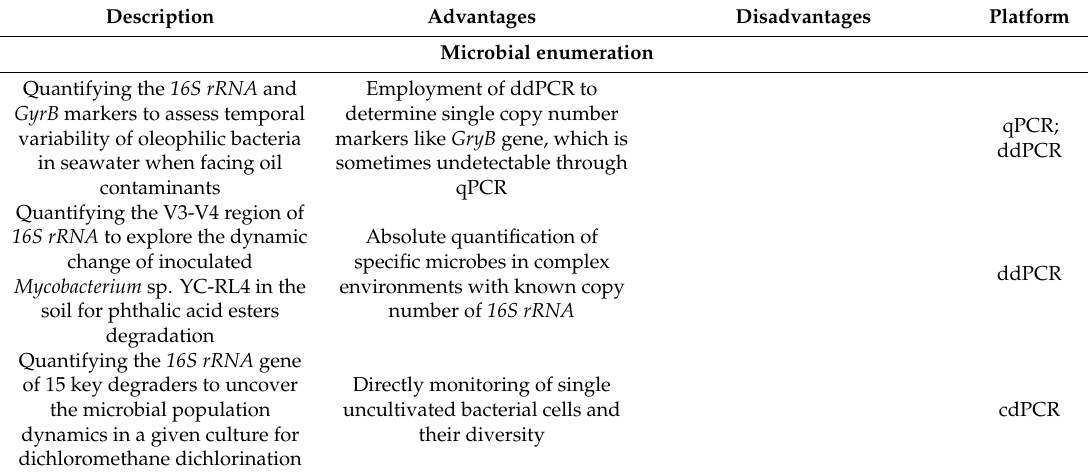
Table 1. The dPCR-based monitoring applications and its superiorities over